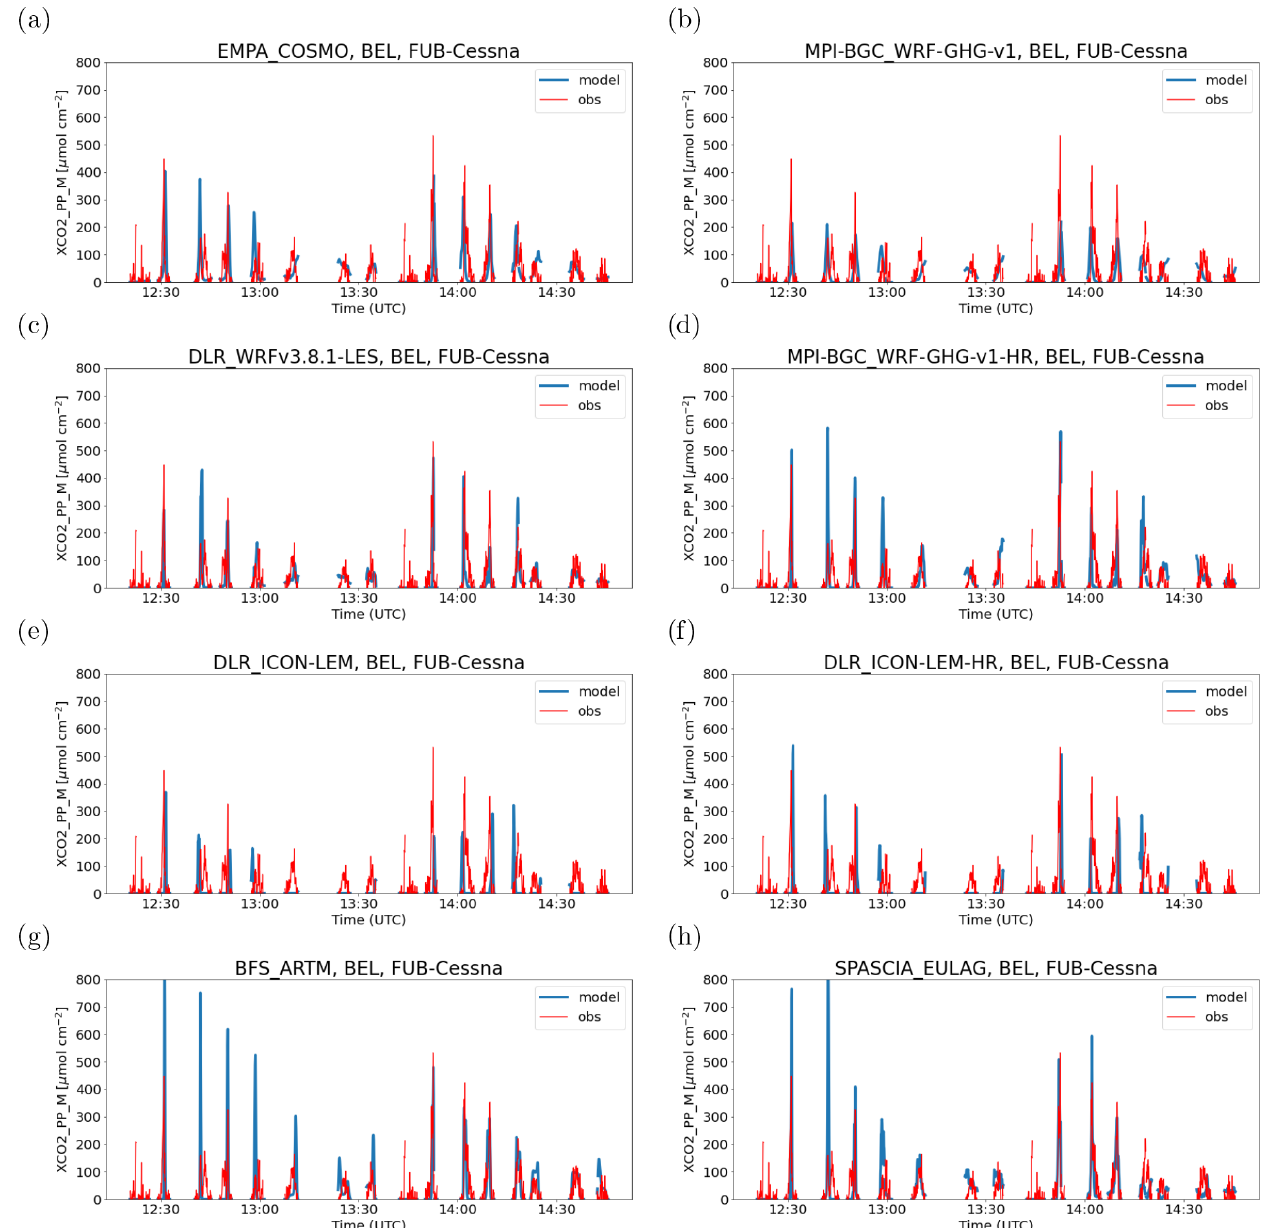
Figure 9. Time series of CO 2 (tracer CO2_PP_M) column enhancements simulated and observed by MAMAP along the FUB Cessna flight at Bełchatów on 7 June 2018. The plumes observed around 12:20 and 13:45UTC, which are not reproduced by any of the models, were measured upwind of the power plant. These plumes are caused by retrieval issues over water surfaces rather by real CO 2 enhancements.